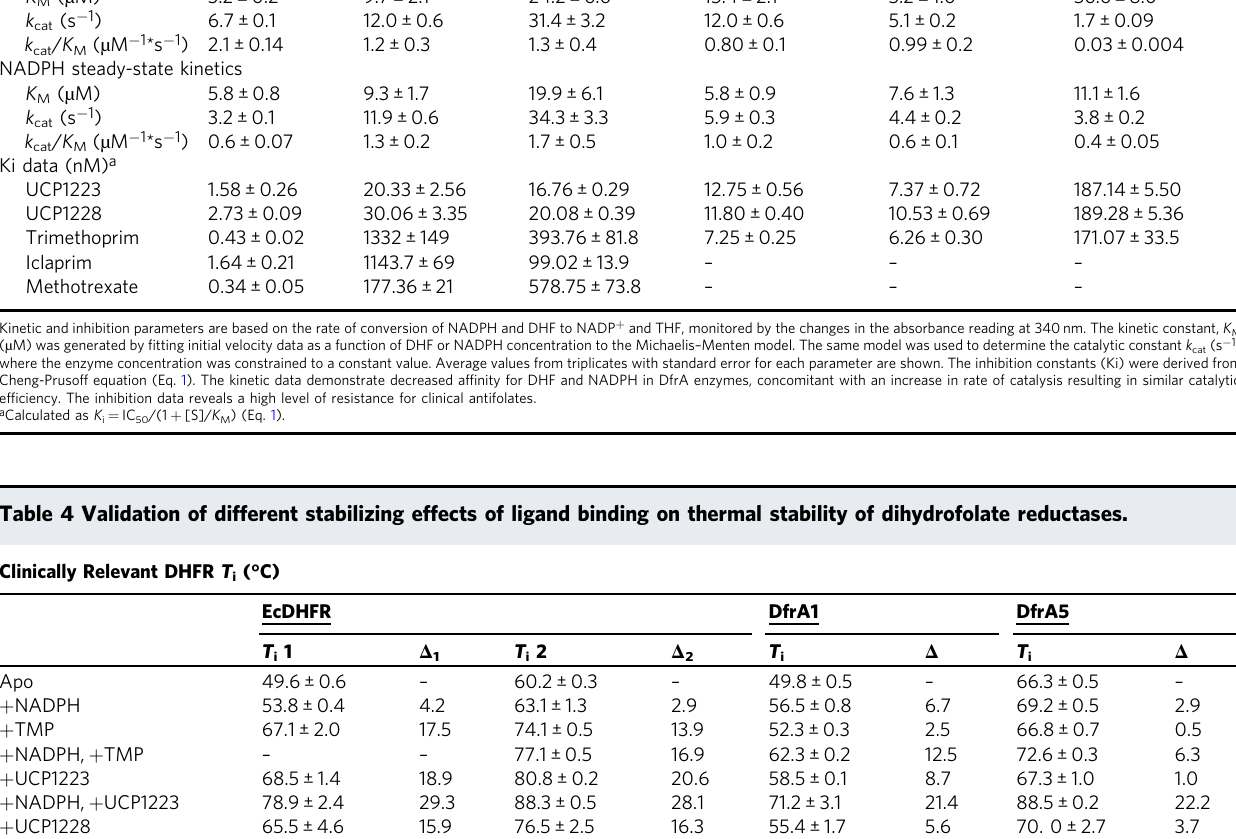
Table 3 Summary of steady-state kinetic and inhibition constants of EcDHFR, DfrA1, and DfrA5. EcDHFR DfrA1